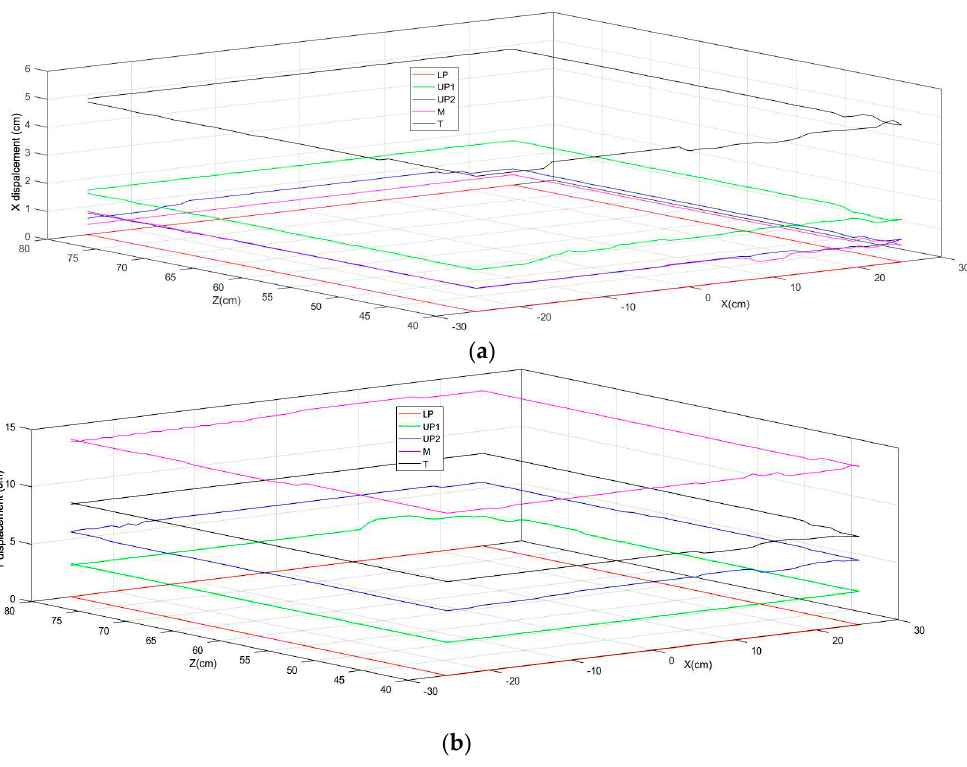
Figure 11. LED positions with respect to LP LED ( a ) X -Displacement ( b ) Y -Displacement.